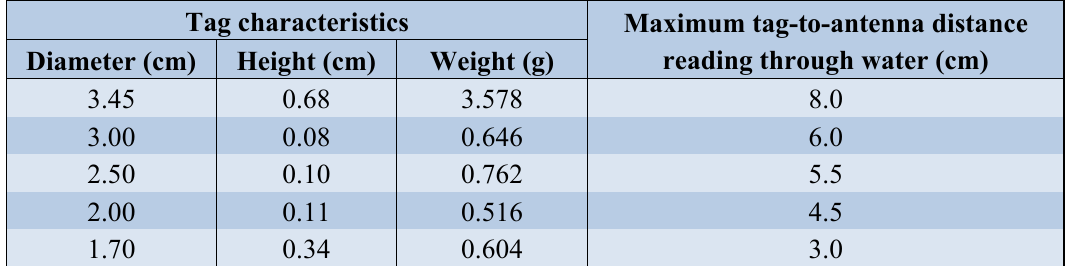
Table 1. Technical specifications of the RFID transponders (tags) emitting at 13.56 MHz, tested to track the behaviour of Nephrops in a laboratory microcosm tank.